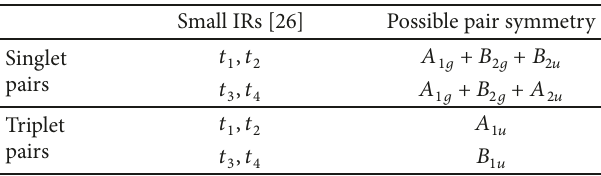
Table 4: Spatial parts of pairs in point 𝑀(𝑏 1 /2, 𝑏 2 /2,0) , space